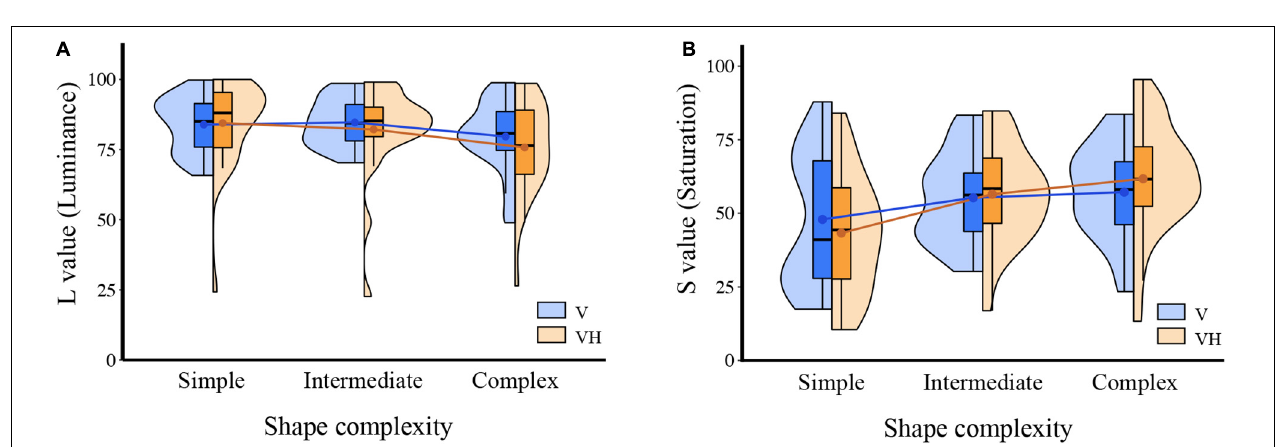
FIGURE 4 | Results from Experiment 2. (A) Violin plots illustrate the estimated distributions of individual mean L value (luminance) in each shape complexity (simple, intermediate, complex) and modality exploration (visual-only, V; visuo-haptic, VH) conditions. The middle horizontal lines on the box plots indicate the median, and the lower and upper ends indicate the first and third quartiles. Dots on the box plots indicate the mean. (B) Violin plots are shown for the result of S value (saturation).